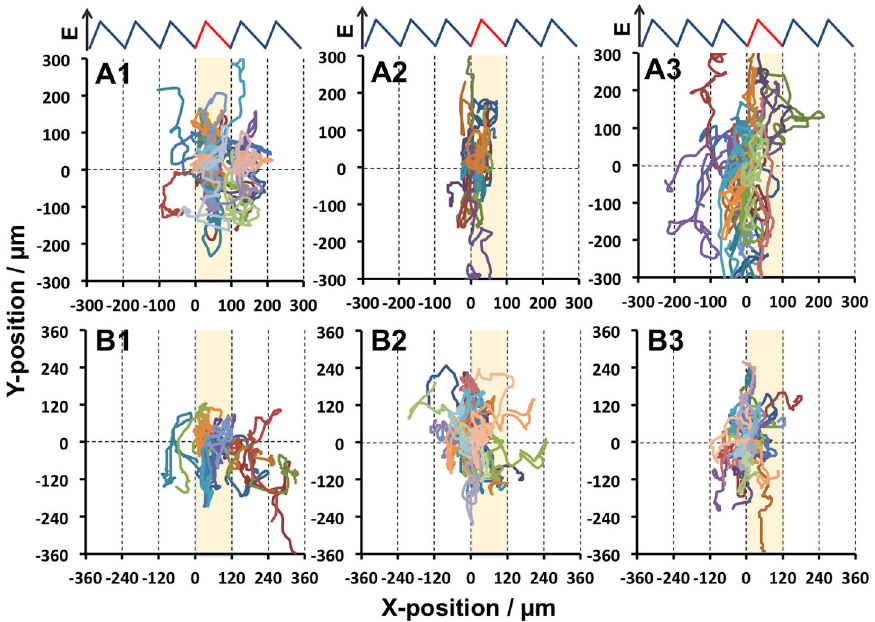
Figure 5. Trajectories of 3T3 fibroblasts cultured on A1-A3 and B1-B3 gels. Time-lapse microscopy was performed for 30 hr and images were acquired at 15 min intervals. The starting position of each cell trajectory was mapped to the origin of the graph. A band of single unit including the origin is highlighted. n=40